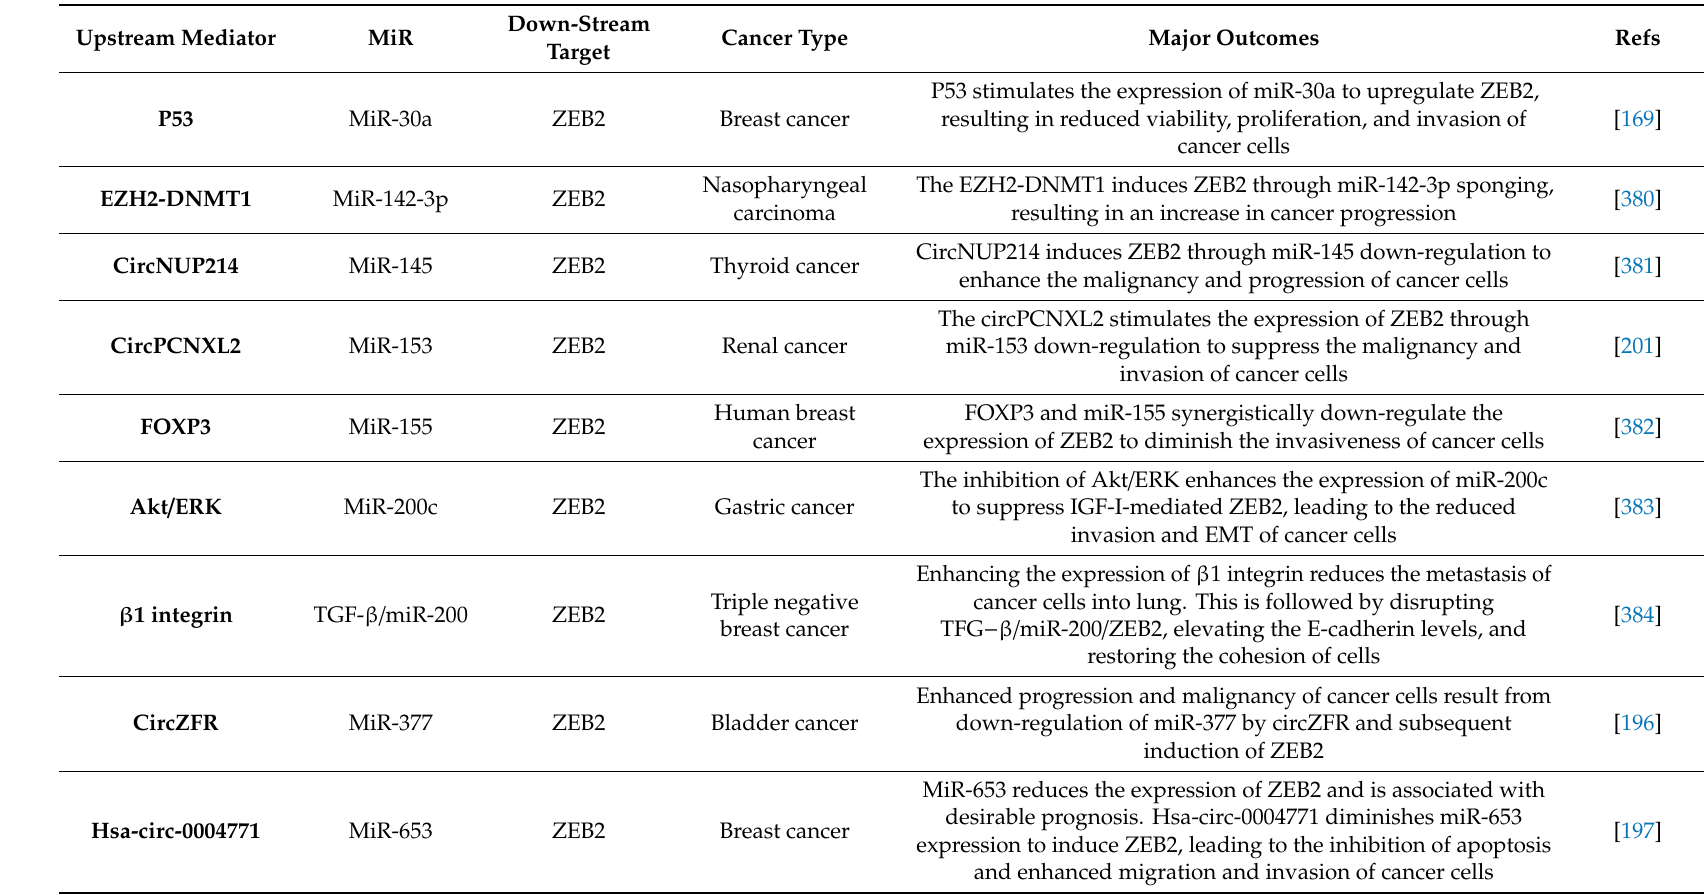
Table 6. miR / ZEB2 regulation by various molecular pathways in di ff erent